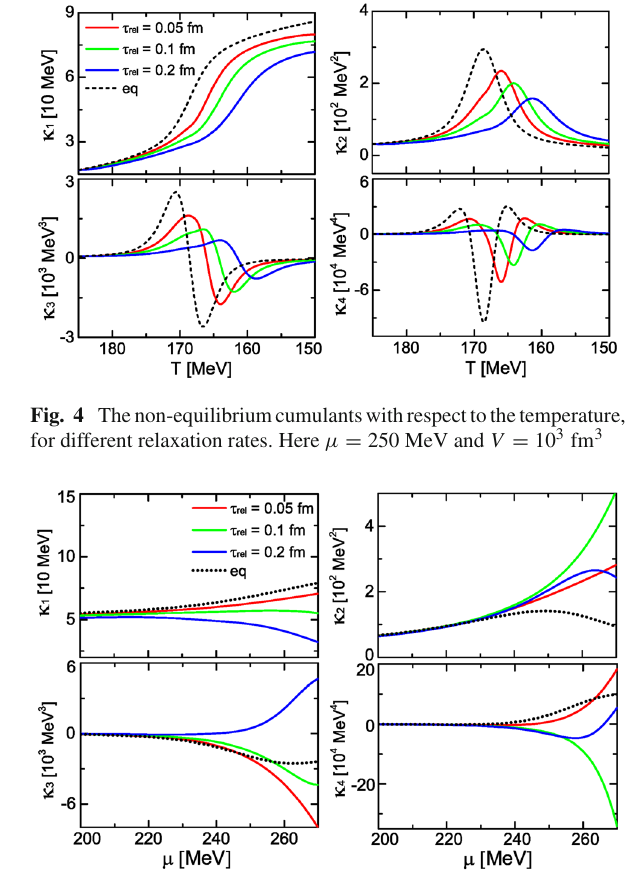
Fig. 5 The non-equilibrium cumulants with respect to the chemical potential on the freeze-out line, for different relaxation